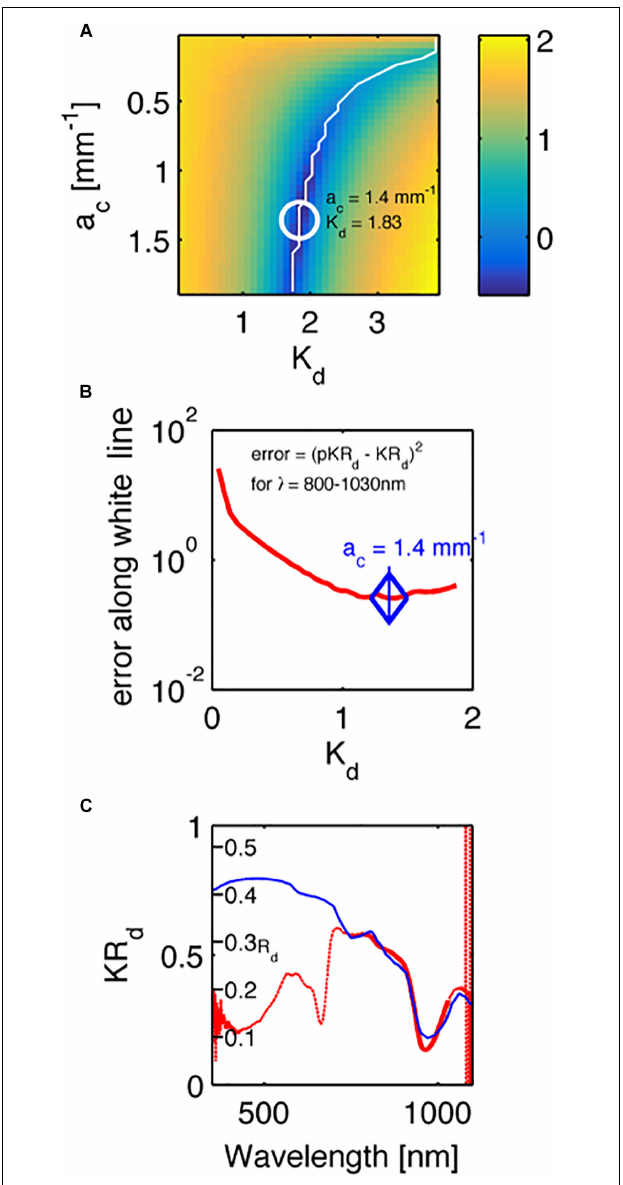
FIGURE 5 | An example fit of the KR d spectrum of a Acropora millepora . (A) A map of the errors in measured KR d vs. predicted pKR d (Eq. 4), as choices of a c and K d were varied. White line indicates a range of minima. White circle indicates the best minimum using least-squares fitting. Color bar is log 10 scale. (B) The profile of the error along the white line in (A) . (C) The experimental spectrum (red line) and the fit to the data from 800 to 1030 nm. The y-axis is the measured KR d . A second set of tic marks labeled R d indicate the true reflectance collected from the 5-mm-dia. spot by the optical fiber probe, as predicted by R d = pKR d /K d .